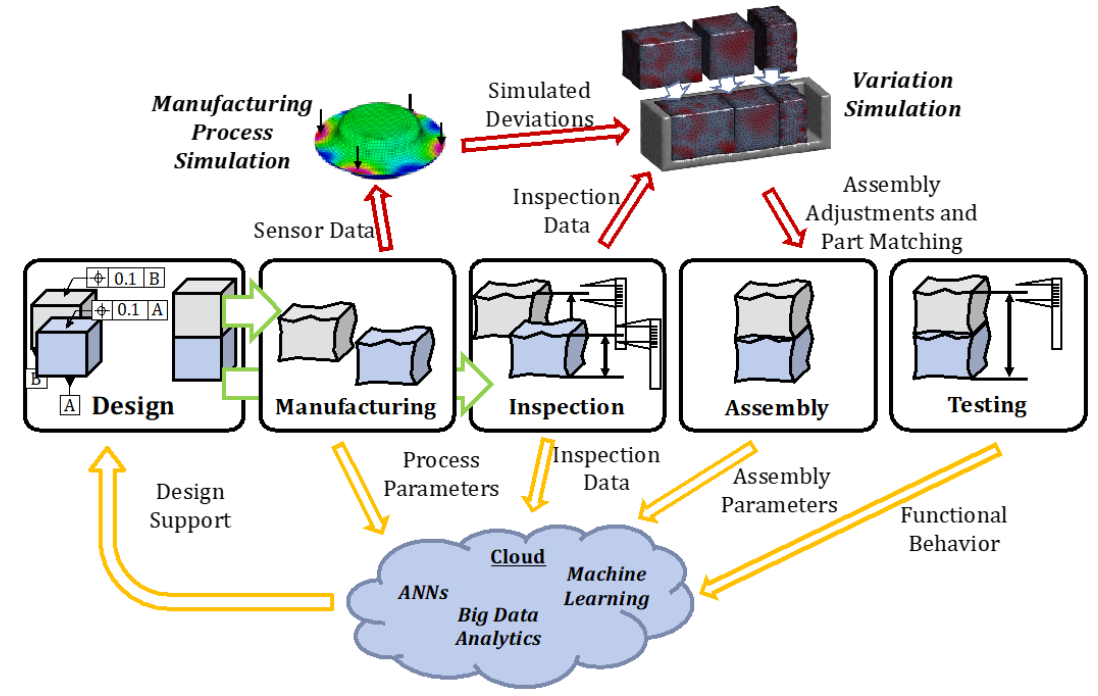
Figure 4. Exemplary tolerancing informatics workflows. ANNs: Artificial Neural